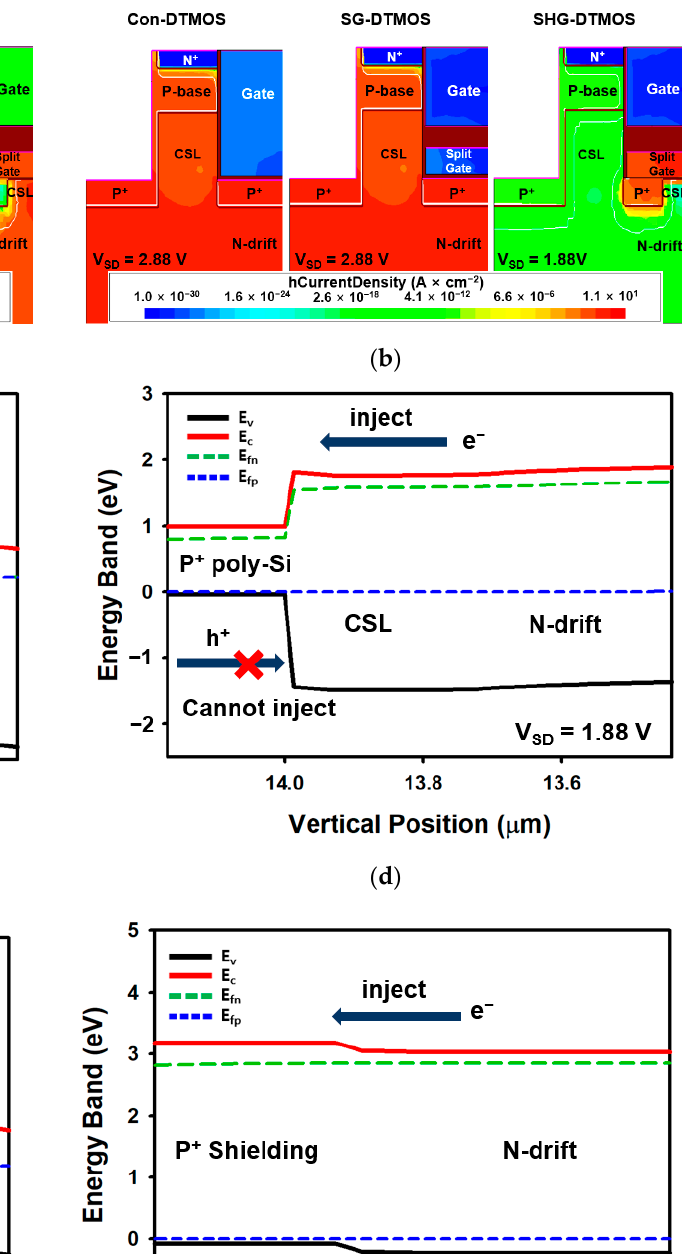
Figure 5. The forward conduction state characteristics of body diodes of Con-DTMOS, SG- DTMOS, and SHG-DMOS.